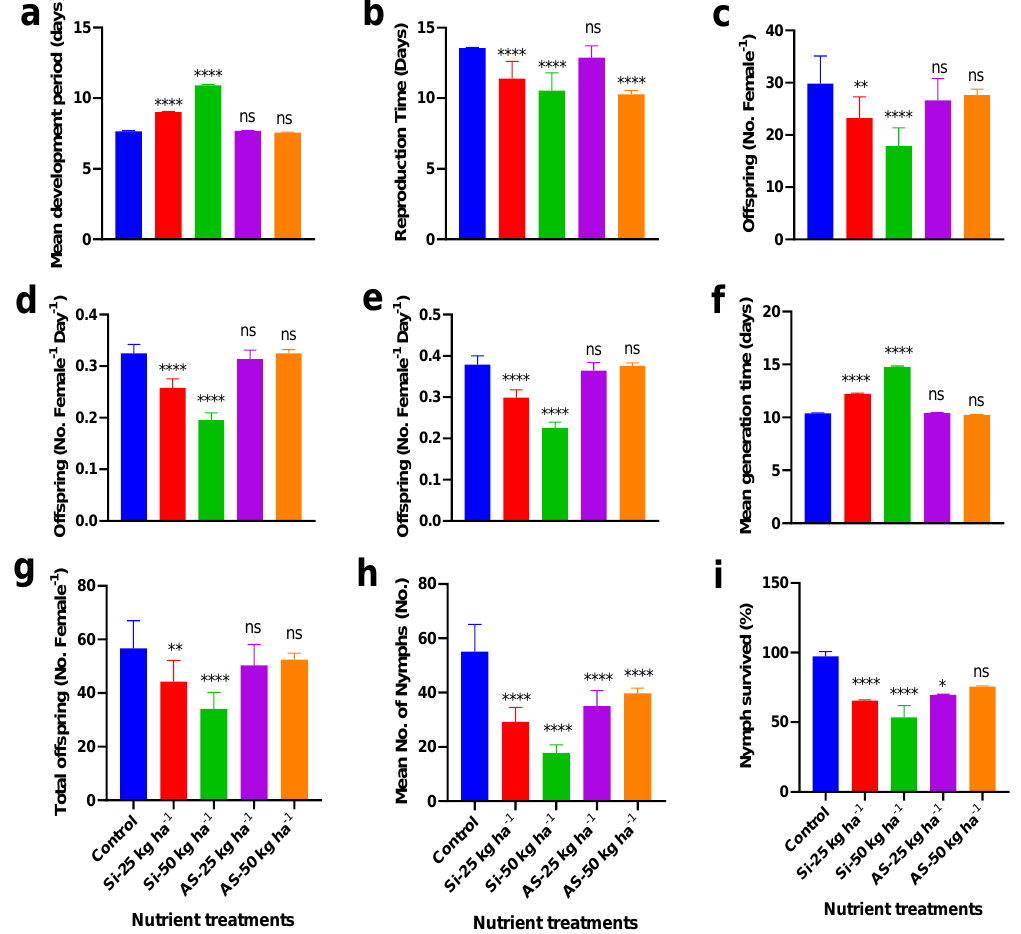
Figure 4. Effects of Si (Silicon) and AS (Ammonium Sulfate) on different fitness attributes of Brevicoryne brassicae compared to the control (Mean ± SD, n = 10). ( a ) Development period (Days). ( b ) Reproduction time (Days). ( c ) Effective fecundity (No. Female − 1 ). ( d ) Intrinsic rate of natural increase (No. Female − 1 Day − 1 ). ( e ) Relative growth rate (No. Female − 1 Day − 1 ). ( f ) Generation time (Days). ( g ) Total progeny production (No. Female − 1 ). ( h ) Progeny nymphs surviving to adulthoods (No. Female). ( i ) Percent progeny nymph survival (%). Statistical significance of P in post hoc tests: ns ≥ 0.05, * <0.05, ** <0.01 ****